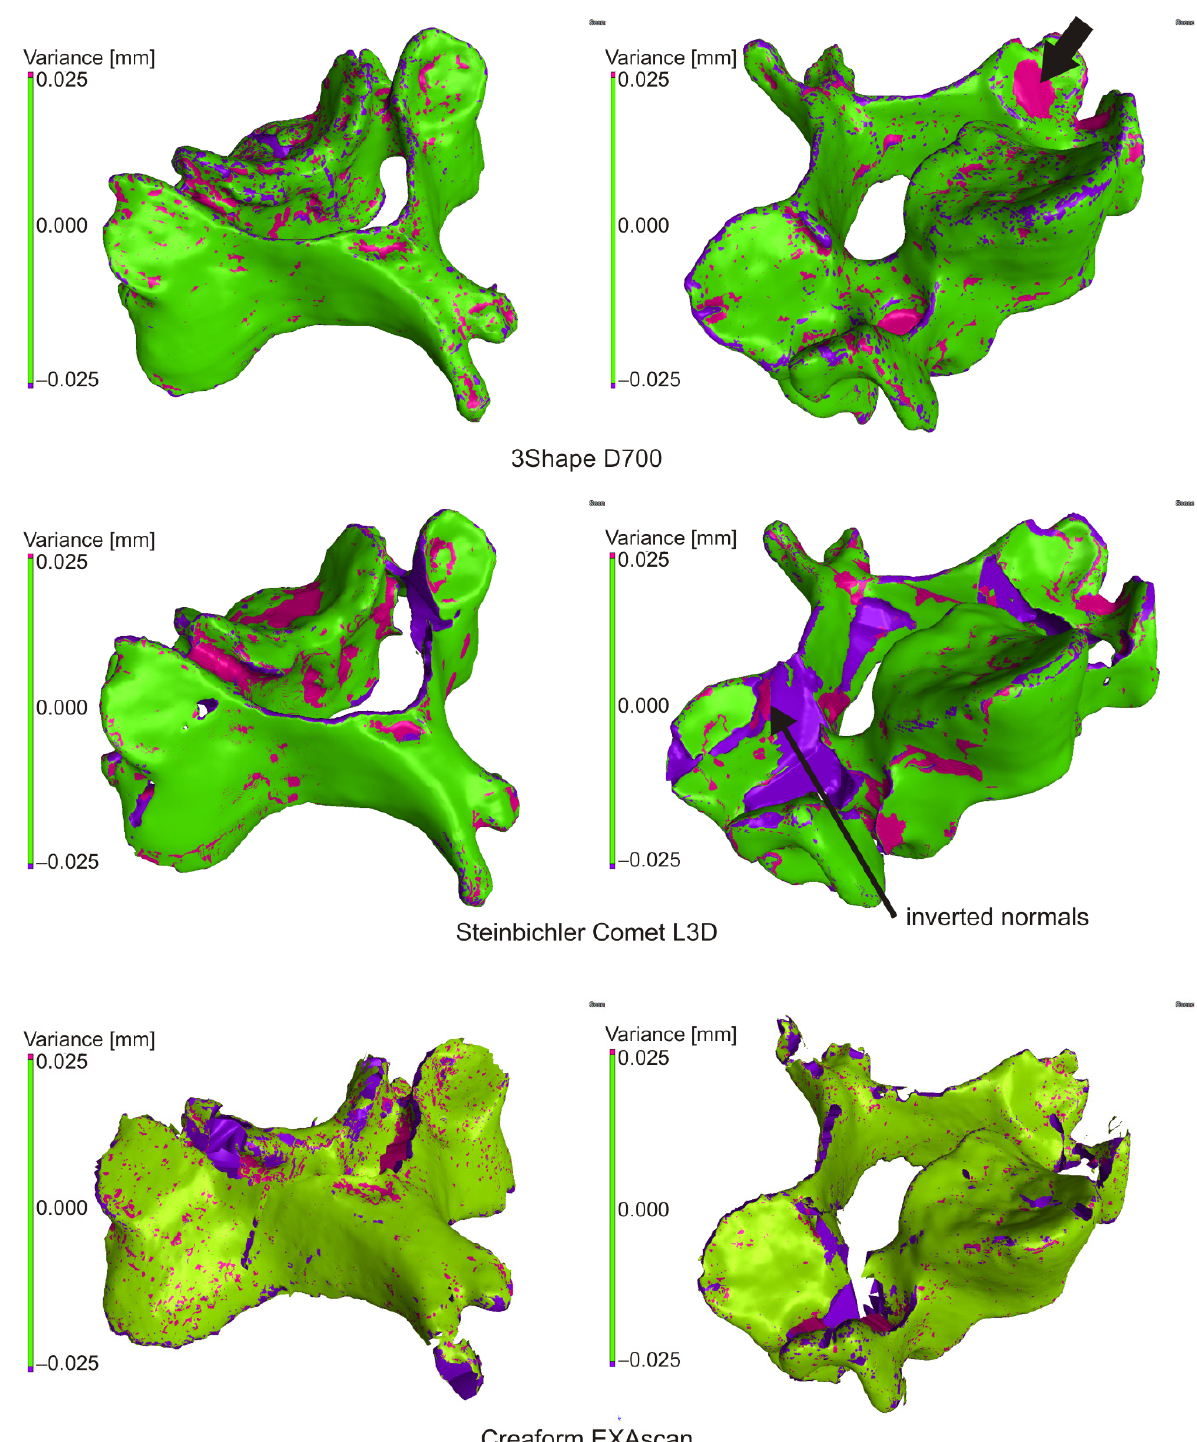
Figure 6. Comparison of mesh and solid model.